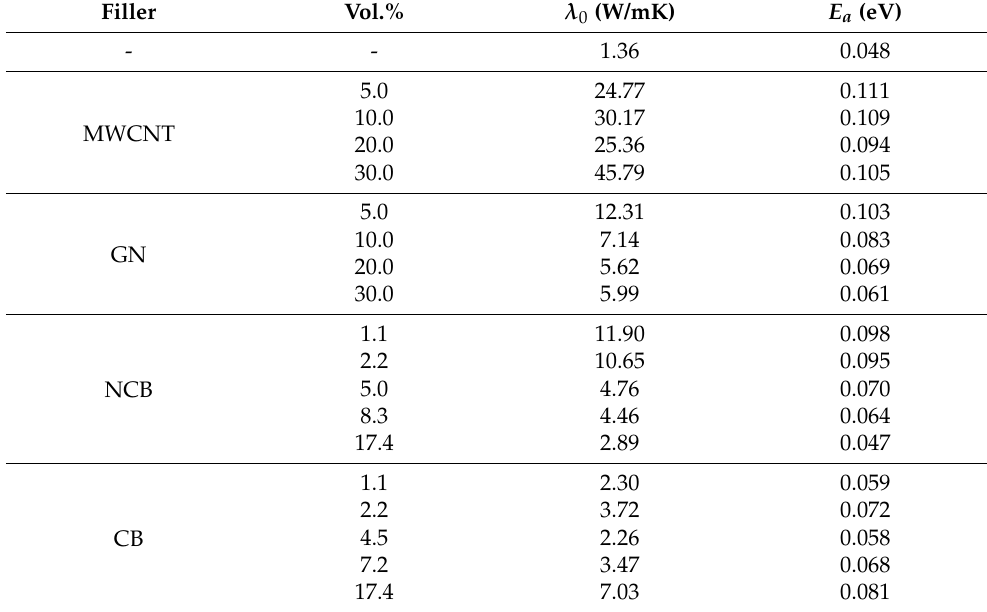
Table 2. Parameters of the Arrhenius equation for PBSA composites. Filler